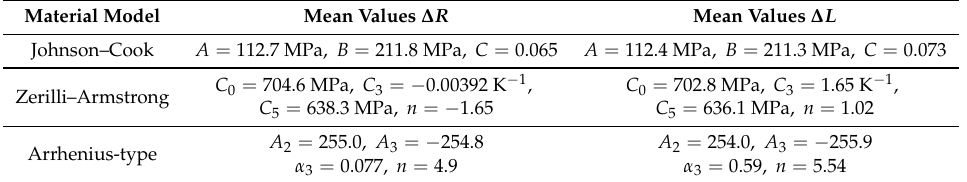
Table 6. A posteriori mean values obtained for each parameter, considering both QoIs, ∆ R and ∆ L , for the calibration of the